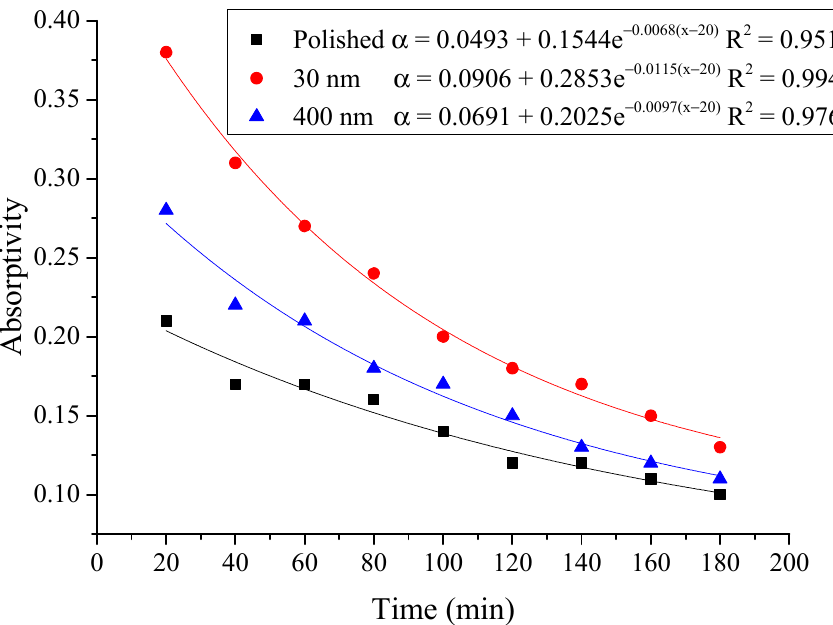
Figure 20. Variation of the average absorptivity for the testing rigs operated under the simulated radiation of 700 W/m 2 .